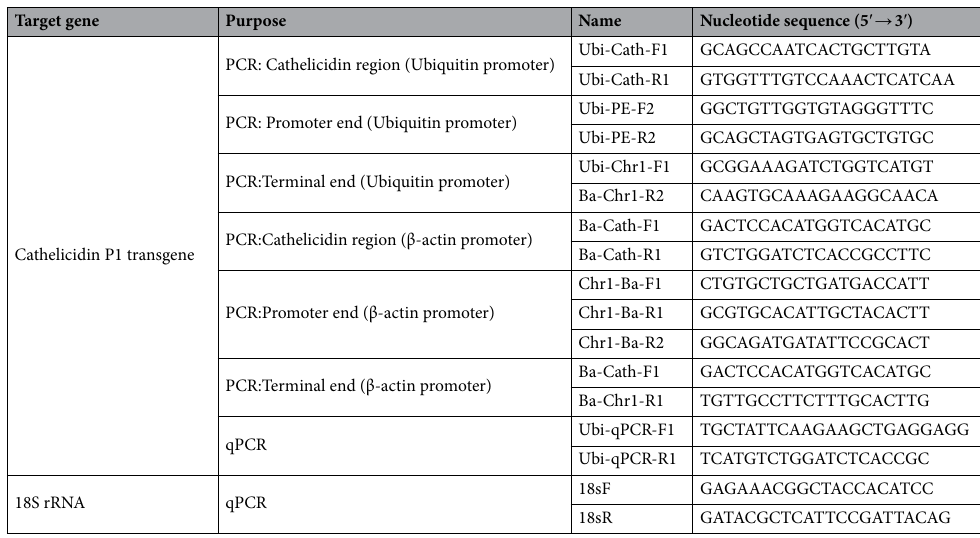
Table 2. Oligonucleotide primers used in determining integration and transgene expression of alligator cathelicidin gene in channel catfish ( Ictalurus punctatus